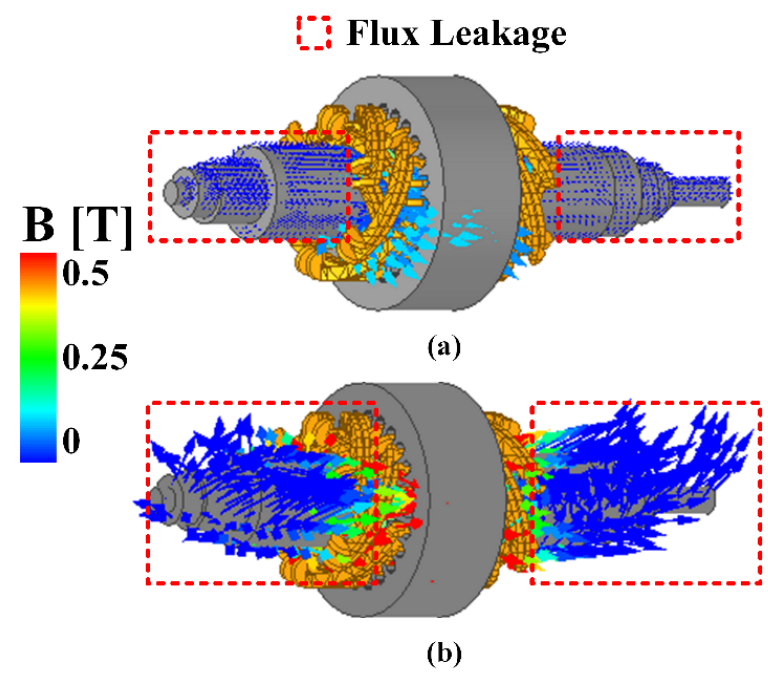
Figure 3. Leakage flux analysis results according to shaft materials: ( a ) titanium shaft and ( b ) SCM440 shaft.